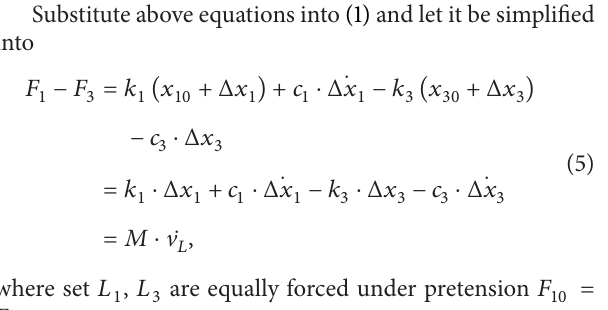
Figure 5: Simplified diagram of underwater vehicle propelled by hydraulic winch, where 𝜔 1 is the angular speed of hydraulic winch rotation, 𝑅 is the radium of drum, 𝜔 𝑐 2 are the elasticity and viciousness of